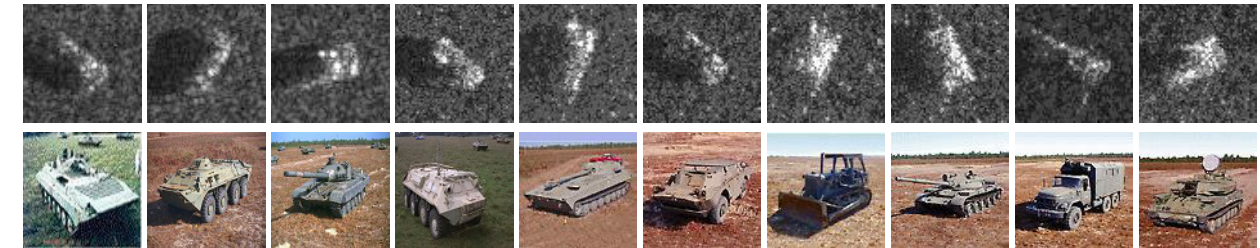
Figure 5. ( Top ) SAR images and ( Bottom ) optical images of ten categories of target samples. According to the order: 2S1, BMP2, BRDM2, BTR60, BTR70, D7, T62, T72, ZIL131, and ZSU23/4.